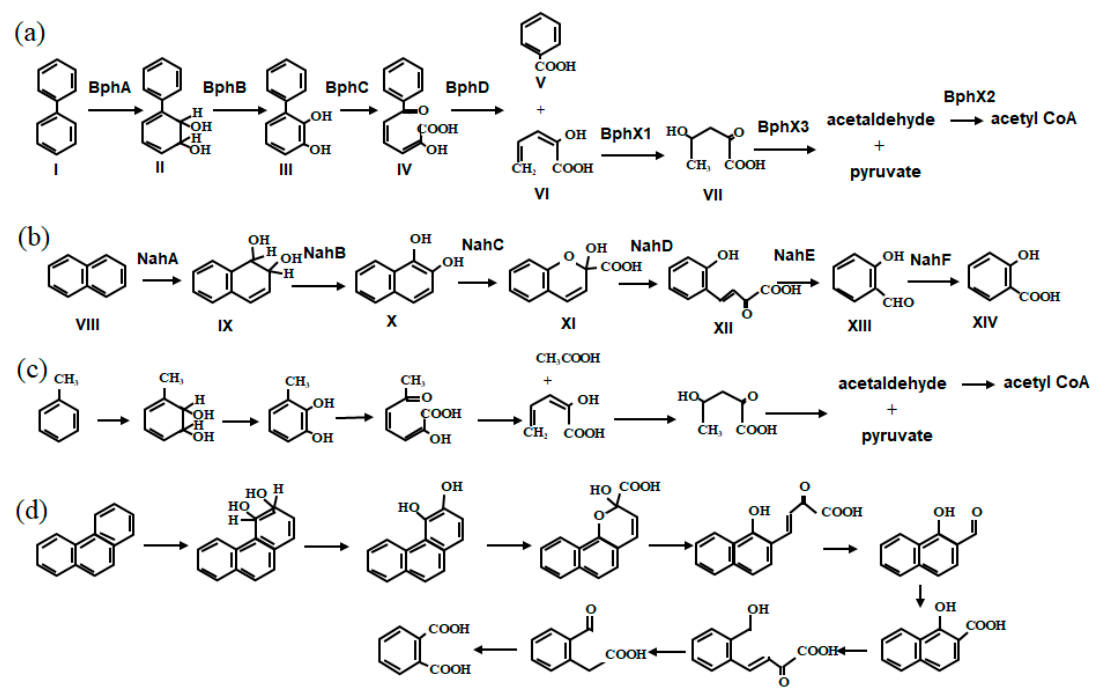
Figure 1. Aerobic degradation pathways for aromatic hydrocarbons encoded on degradative ICEs: ( a ) biphenyl, ( b ) naphthalene, ( c ) toluene, and ( d ) phenanthrene. The names of the intermediate compounds are as follows: biphenyl (I), cis -2,3-dihydroxy-4-phenylhexa-4,6-diene (dihydrodiol com- pound, II), 2,3-dihydroxybiphenyl (III), 2-hydroxy-6-oxo-6-phenylhexa-2,4-dienoic acid (IV), benzoic aid (V), 2-hydroxypenta-2,4-dienoic acid (VI), 4-hydoxy-2-oxovaleric acid (VII), naphthalene (VIII), cis -1,2-dihydroxy-1,2-dihydronaphthalene (IX), 1,2-dihydroxynaphthalene (X), 2-hydroxychromene-2- carboxylate (XI), o -hydroxybenzylidenepyruvate (XII), salicylaldehyde (XIII), and salicylic acid (XIV). Enzyme names on each arrow are as follows: BphA, biphenyl 2,3-dioxygenase; BphB, 2,3-dihydro- 2,3-dihydroxybiphenyl dehydrogenase; BphC, 2,3-dihydroxybiphenyl 1,2-dioxygenase; BphD, 2- hydroxy-6-oxo-6-phenylhexa-2,4-dienoate hydrolase; BphX1, 2-hydroxypenta-2,4-dienoate hydratase; BphX2, acetaldehyde dehydrogenase; BphX3, 4-hydoxy-2-oxovalerate aldolase; NahA, naphtha- lene 1,2-dioxygenase; NahB, 1,2-dihydroxy-1,2-dihydronaphthalene dehydrogenase; NahC, 1,2- dihydroxynaphthalene dioxygenase; NahD, 2-hydroxychromene-2-carboxylate isomerase; NahE, trans - o -hydroxybenzylidenepyruvate hydratase-aldolase; and NahF, salicylaldehyde dehydrogenase. The intermediate compound names and enzyme names in ( c , d ) are described in references [17] and [11],